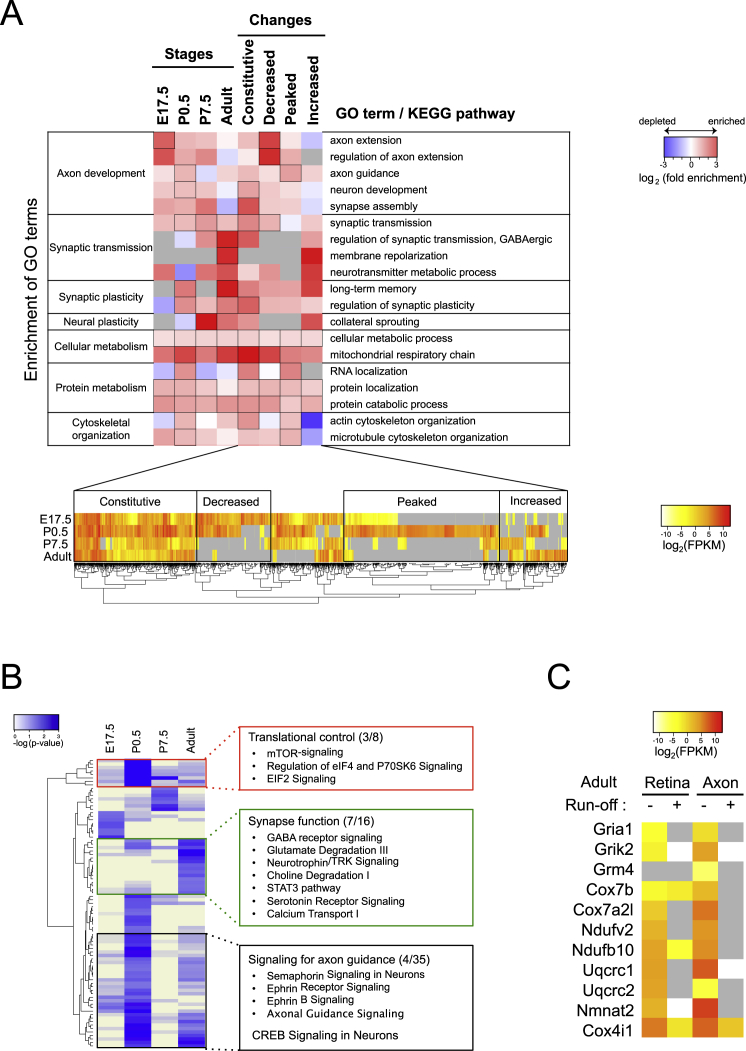
Gene Set Enrichment Analysis Describing the Developmental Changes of Translated Genes in RGC Axons, Related to Figure 4(A) The upper heat map displays the enrichment of GO terms or KEGG pathways for axonally translated genes. Each row in the heat map corresponds to a single GO term. Genes are clustered either by stage-specific expression (“stages”) or hierarchical clustering (lower heat map) according to their developmental changes (“changes”).(B) Ingenuity pathway analysis (IPA) to identify canonical pathways associated with the axonal translatome. Each row represents a single pathway (blue, enriched). The right panel shows lists of pathways extracted from each cluster.(C) A heatmap showing the log2 (read count) for adult samples with and without ribosome run-off. Each row in the heat map corresponds to a single gene.